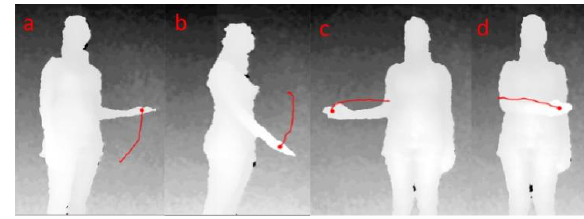
Fig. 2. Movements used to control GestureChair: (a) elbow flexion, (b) elbow extension, (c) lateral rotation of the shoulder with the elbow flexed and (d) medial rotation of the shoulder with the elbow flexed.